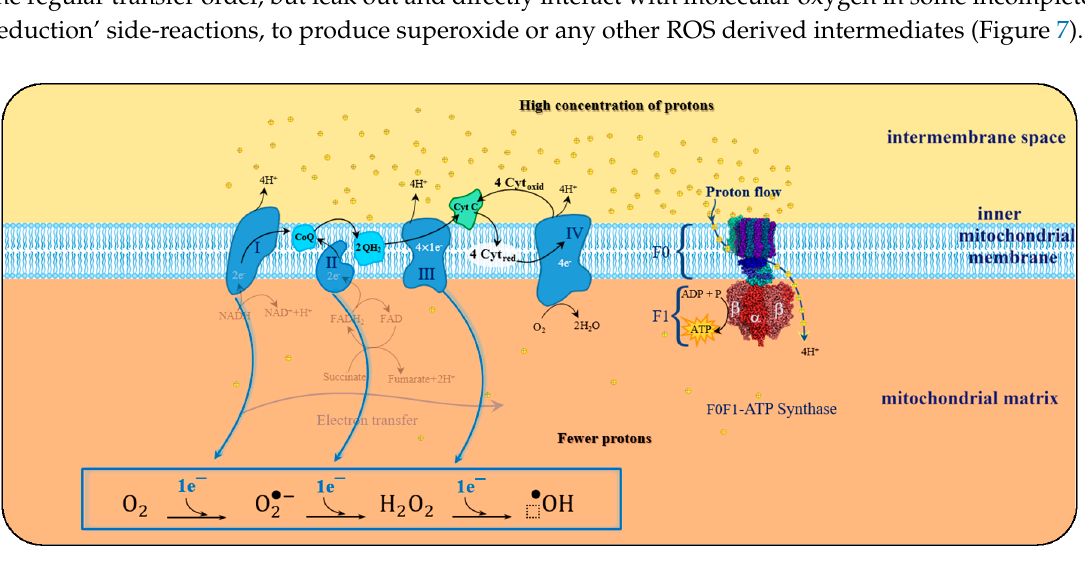
Figure 6. Schematic illustration of - Series of one-electron reaction that occurs during the ETC process. Due to the electrons leaked during the ETC of OP, different ROS will outcome from the sequence one-electron transference to molecular oxygen, yielding the prevalent endogenous ROS (shown in